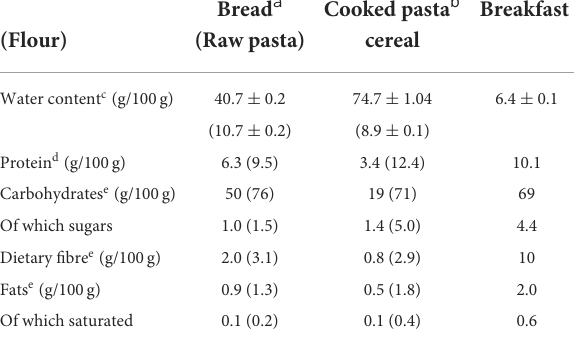
TABLE 1 Nutritional composition of bread, pasta and breakfast cereal. Bread a Cooked pasta b